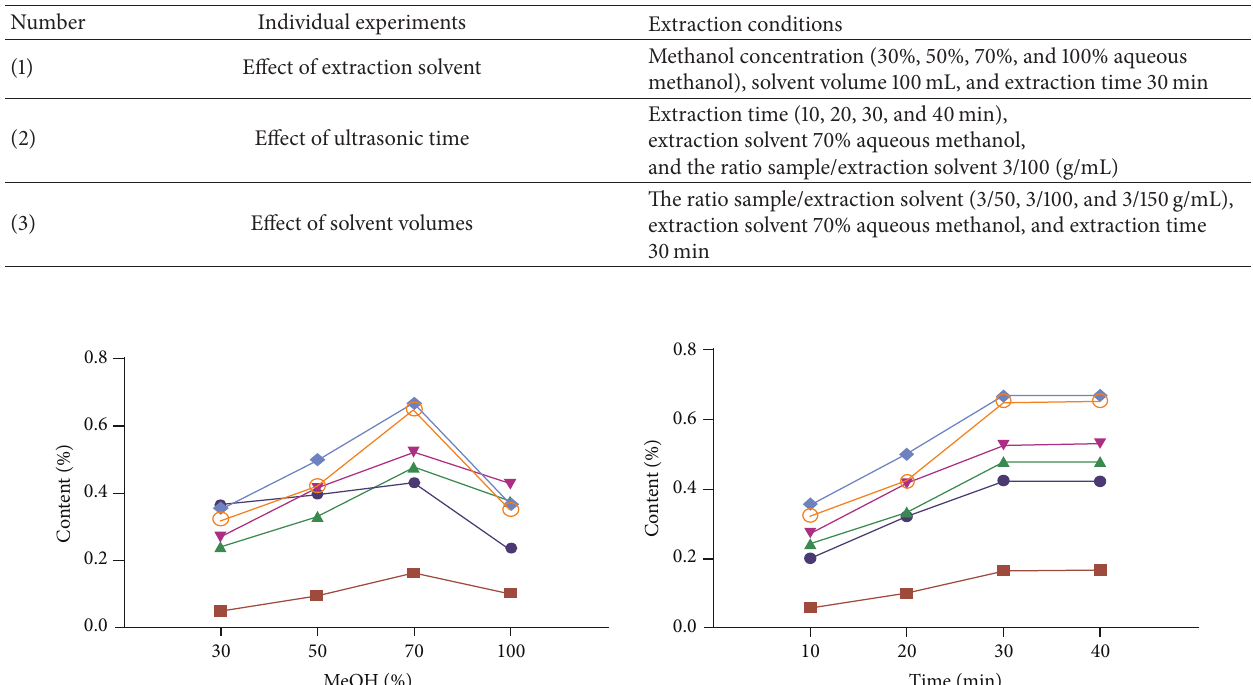
Table 2: The different ultrasonic bath extraction conditions (see Figure 3).